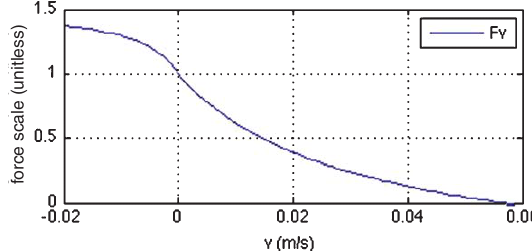
Fig. 3. A plot of the velocity force relationship, F v